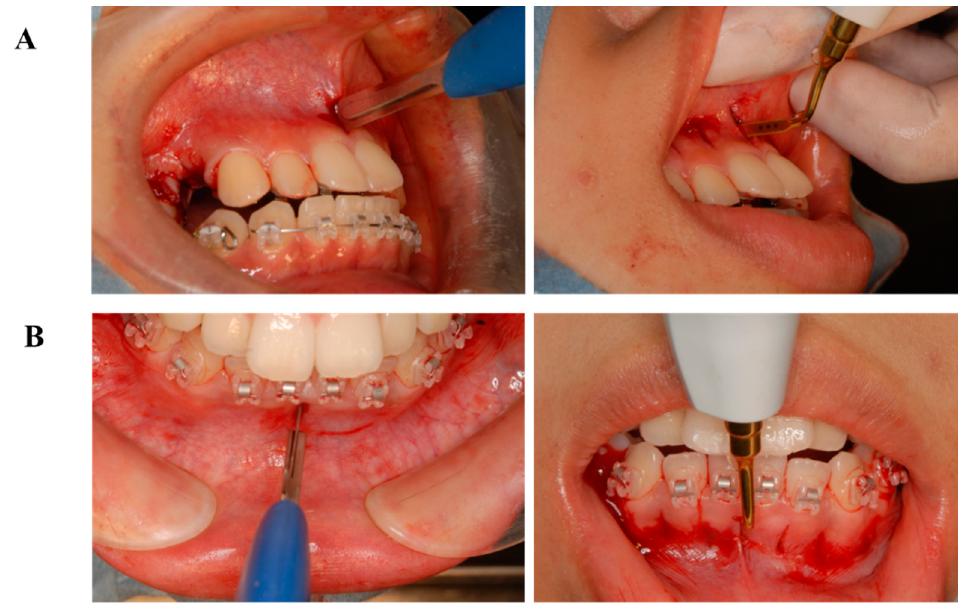
Figure 11. Progress intraoral photographs of corticision and piezocision ( A ), Maxilla; ( B ), Mandibular). The corticision procedure was performed between the lower canine to canine areas. Subsequently, the patient underwent the piezocision procedure.